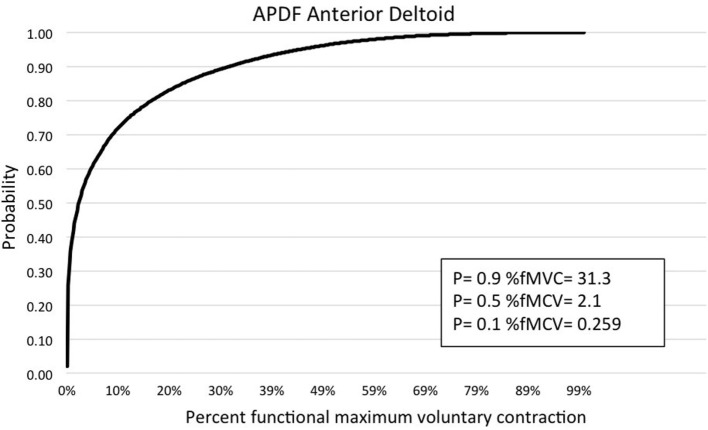
Graphic representation of typical APDF of the anterior deltoid.